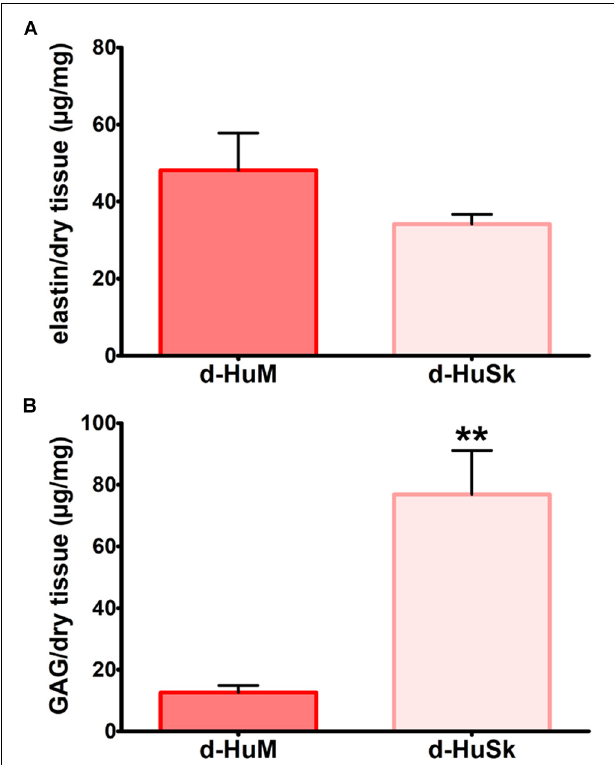
FIGURE 3 | Comparative analysis of the content of elastin and GAGs in decellularized human myocardium (d-HuM) and d-HuSk. Graphs comparing the content of elastin (A) and GAG (B) between d-HuM and d-HuSk evaluated by specific quantitative dye-binding assays. Double asterisks indicate very significant difference (** p ≤